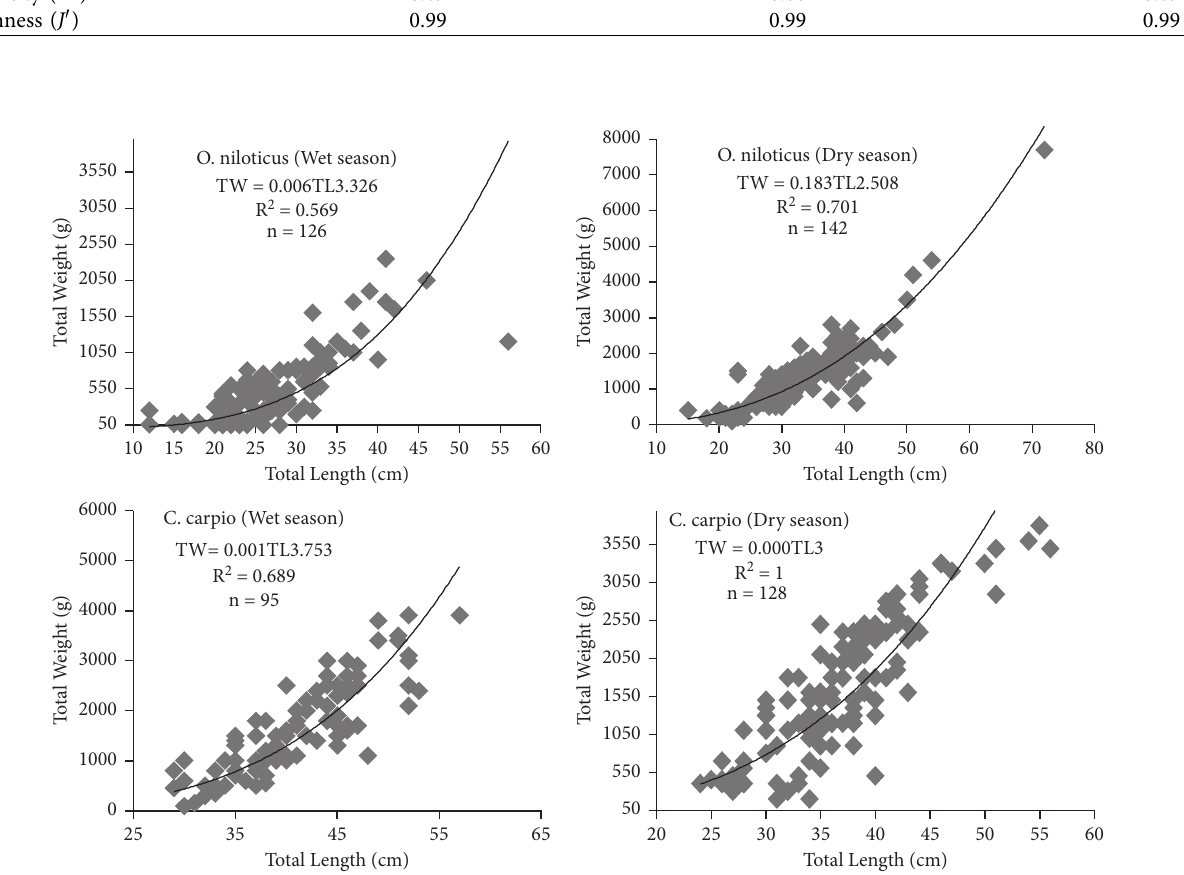
Figure 2: Length-weight relationships of two fish species recorded in the present study.